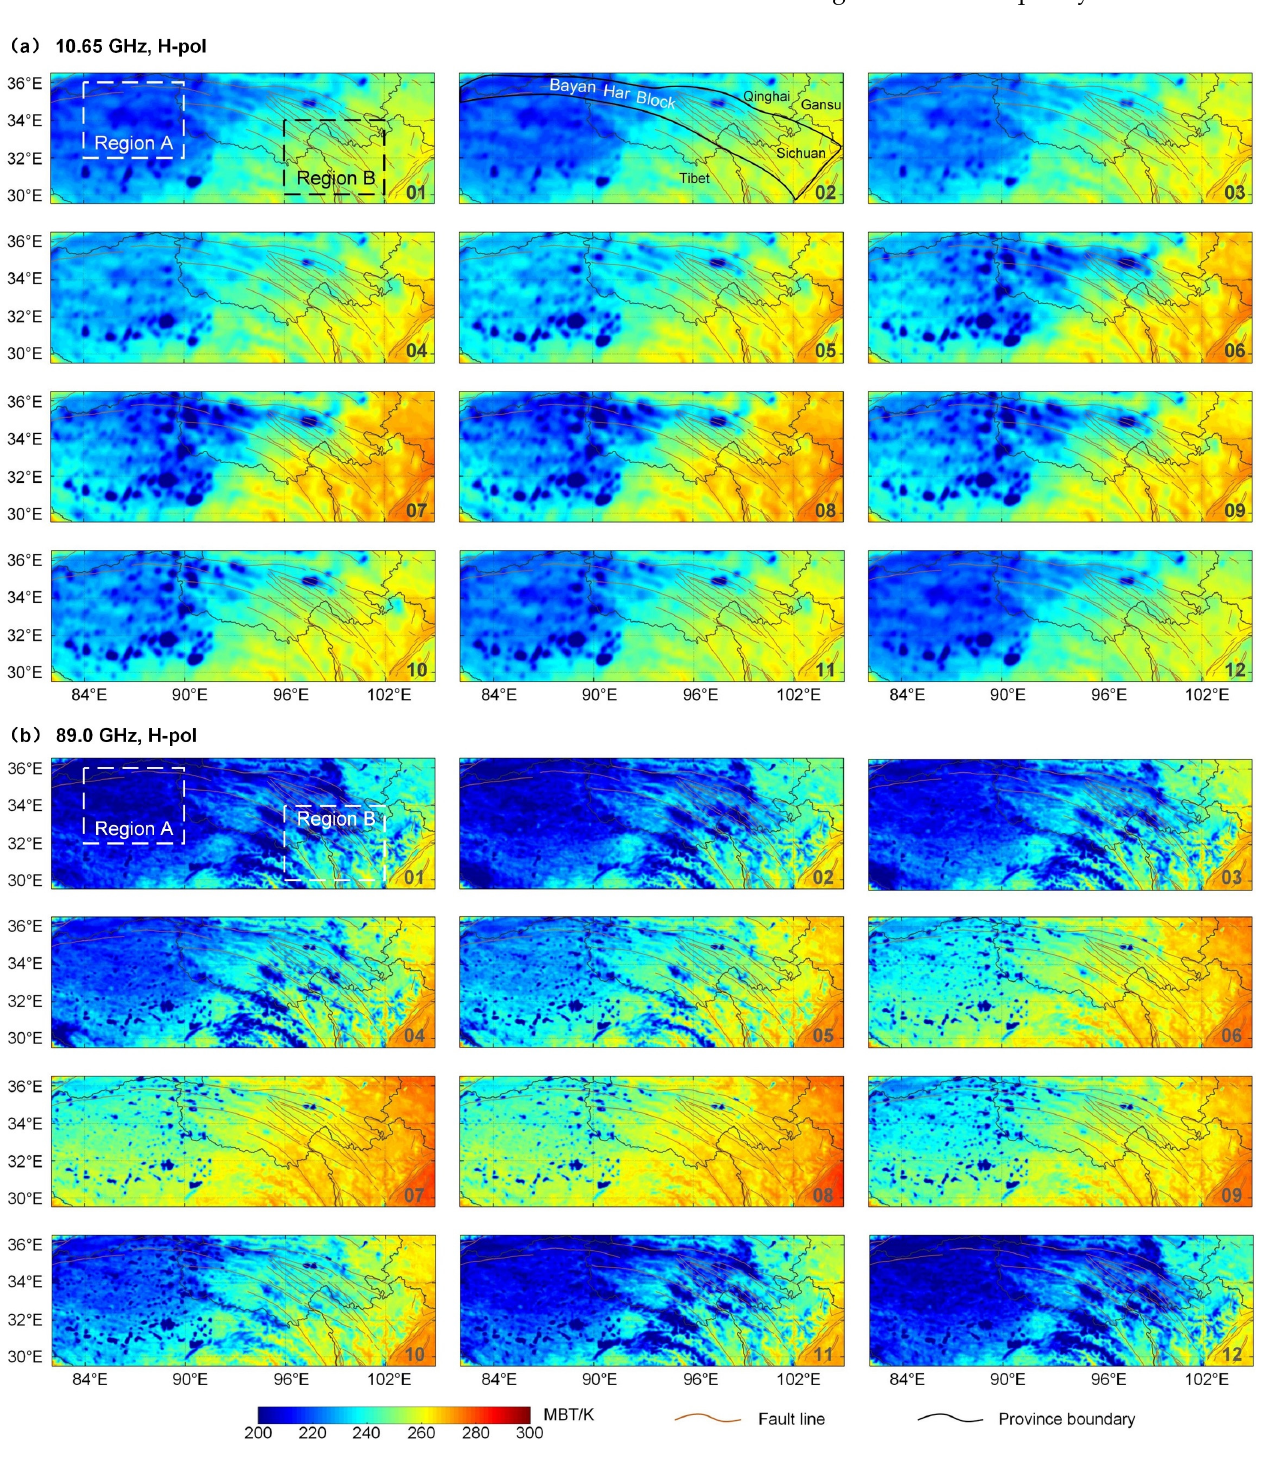
Figure 2. Monthly mean MBT background in the Bayan Har block and its surrounding area at 10.65 GHz ( a ) and 89.0 GHz ( b ) with H-pol (from January to December). The calculation was based on MBT data from the same month in different years.